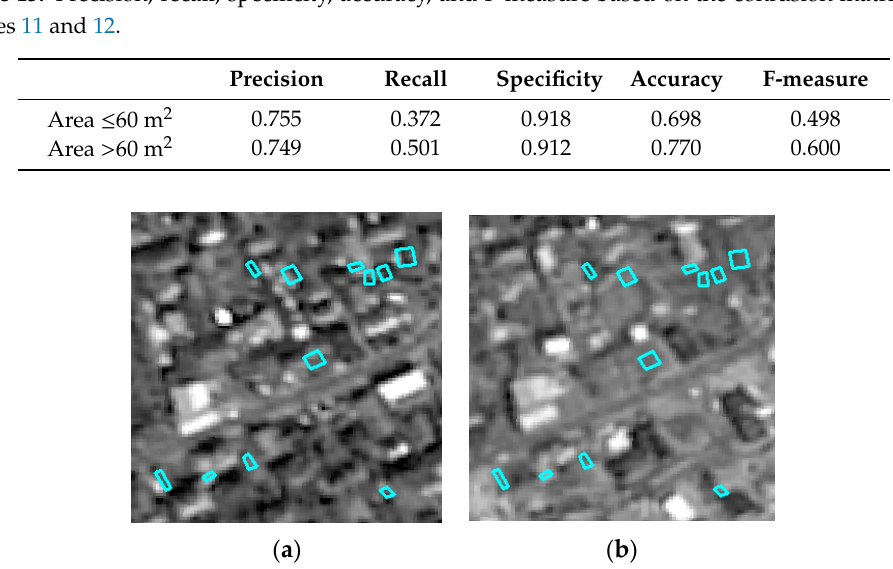
Figure 22. Examples of false negative (FN) estimation due to small areas of demolished buildings drawn in blue outline on a: ( a ) 20 March 2016 SPOT image; and ( b ) 25 March 2018 SPOT image.